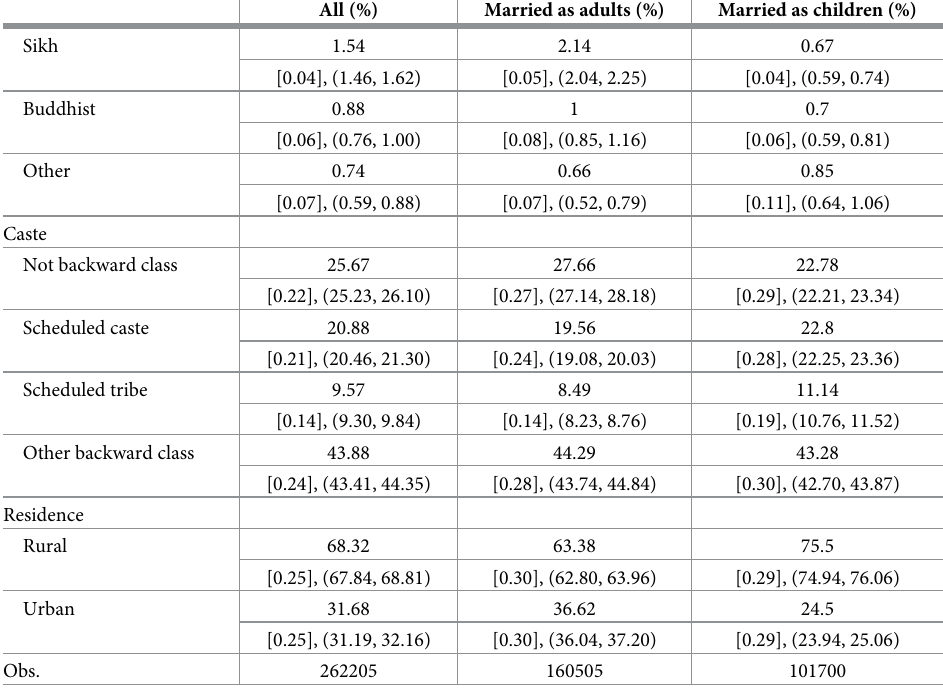
Estimates were obtained using complex survey weights. Linearized standard errors are in square brackets. 95% confidence intervals are in parenthesis. Shares add to 100 across rows for respective